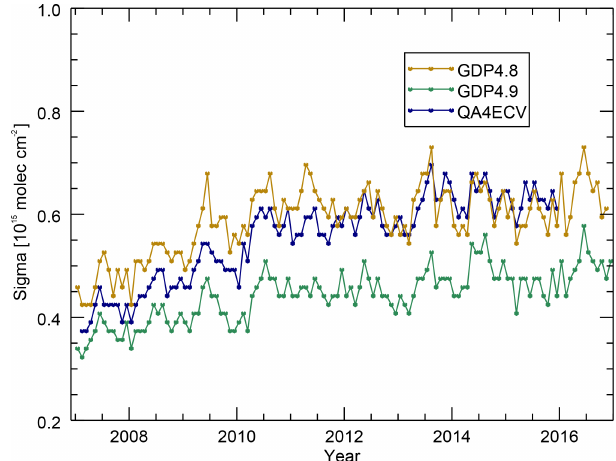
Figure 6. Temporal evolution of the NO 2 slant column errors from the operational GDP 4.8 product (brown, January 2007– December 2016), the improved GDP 4.9 algorithm (green, Jan- uary 2007–December 2016), and the QA4ECV dataset (blue, Febru- ary 2007–December 2015) for GOME-2A, using deviations of NO 2 slant columns from box (2 ◦ × 2 ◦ ) mean values over the tropical Pa- cific (20 ◦ S–20 ◦ N, 160–180 ◦